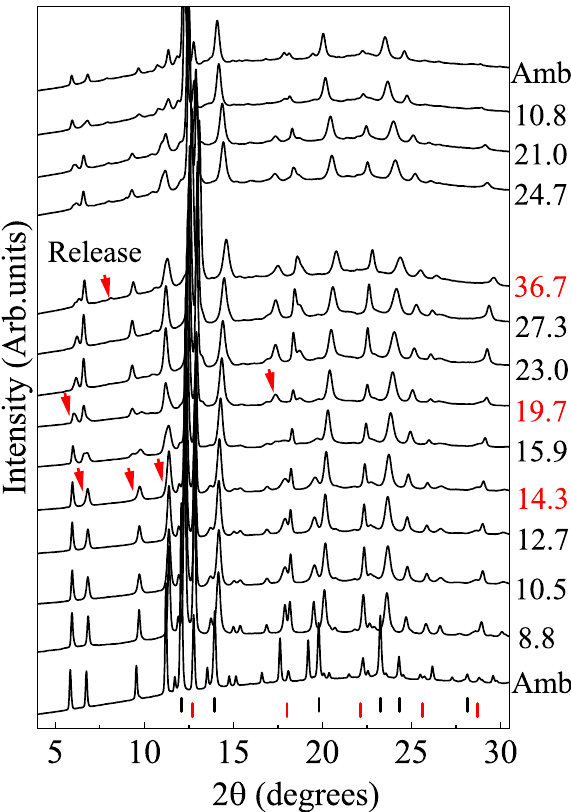
Figure 5. Pressure-dependent XRD patterns at few selected pressures. The pressure values on the right are in GPa. The red arrows indicate the emerging new reflections. The red and black ticks at the bottom are from Au (pressure marker) and W (gasket), respectively.